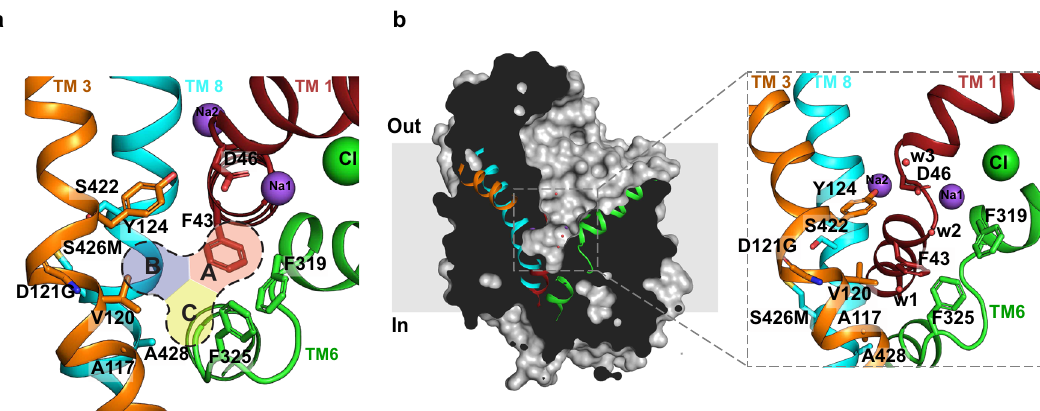
Fig. 1 Organization of primary binding site and substrate-free dDAT. a Close-up view of substrate-free dDAT subB -binding pocket, showing the organization of subsites A, B, C of the primary binding site colored as red, blue, and yellow, respectively. b Surface representation of substrate-free dDAT subB structure viewed parallel to the membrane plane. Helices TM1, TM3, TM6, and TM8 are colored as red, orange, green, and cyan, respectively. Inset shows the residues lining the primary binding pocket with water molecules indicated as